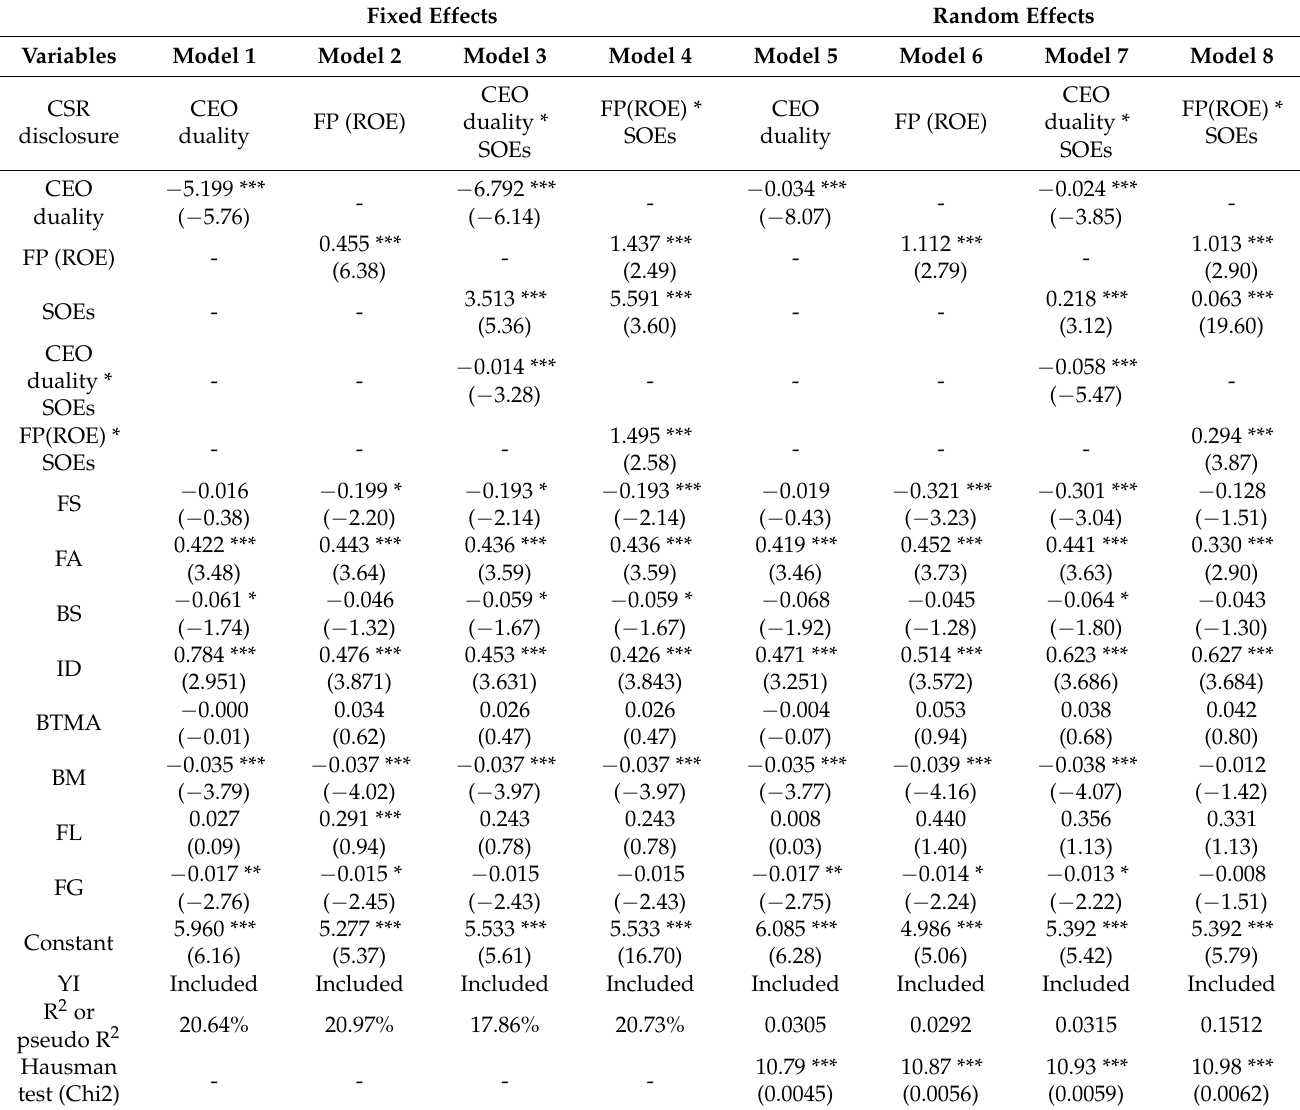
Table 5. Results of impact of CEO duality and financial performance (ROE) on CSR disclosure, and moderating role of SOEs (panel data analysis with fixed effects and random effects robustness